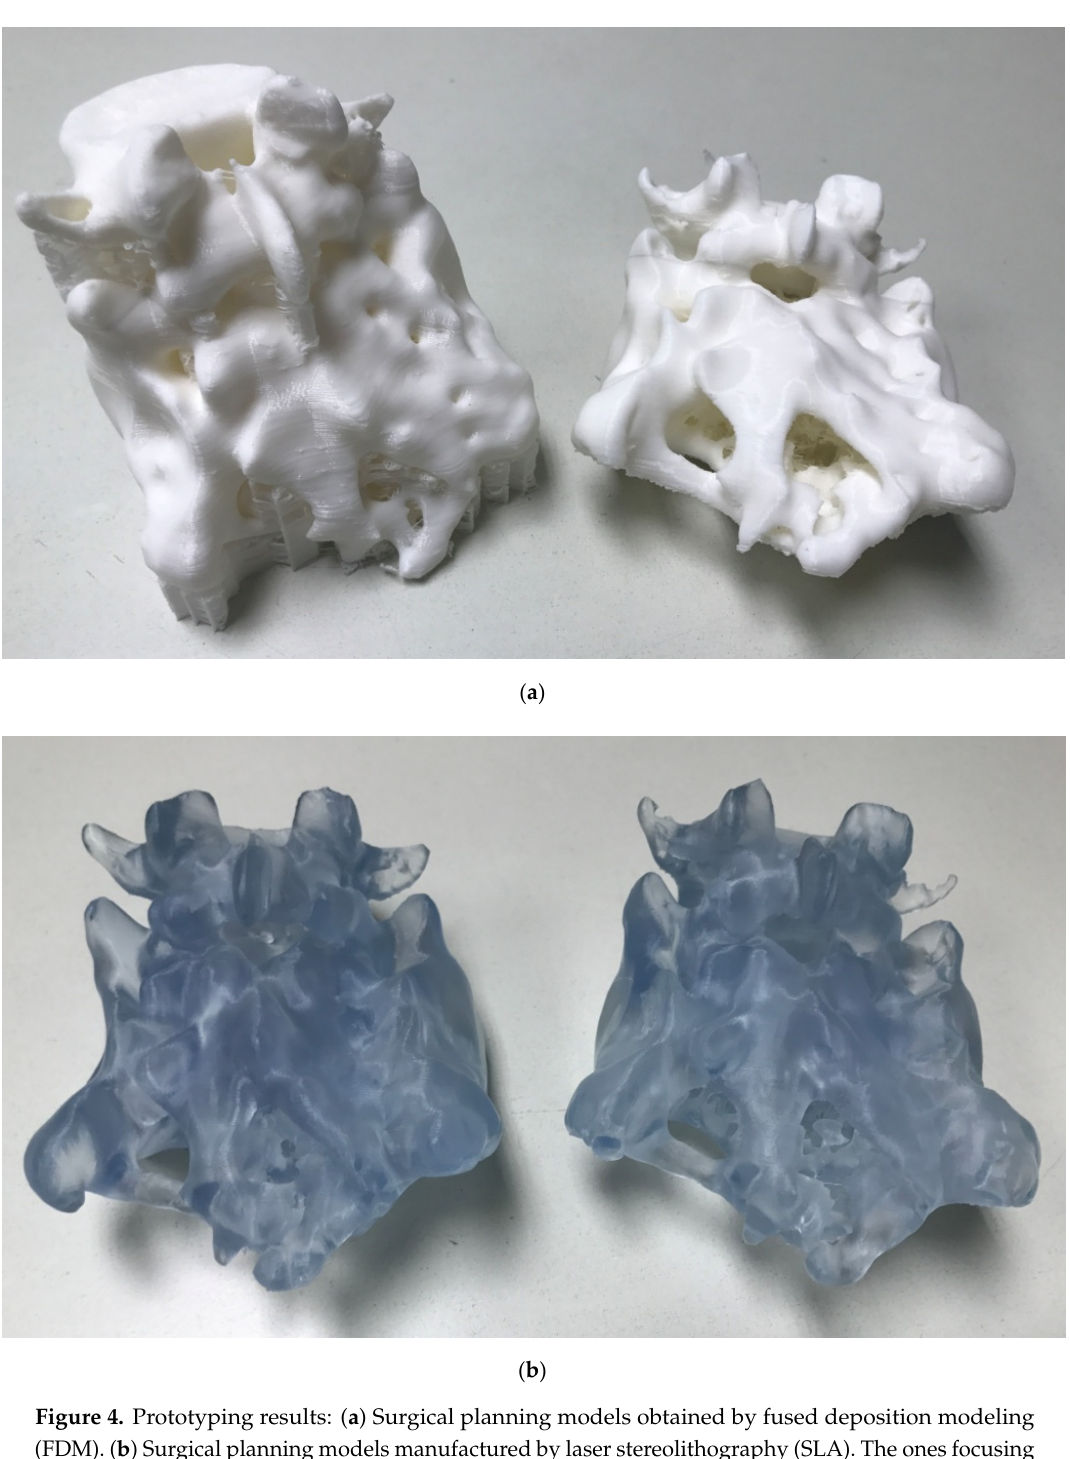
Figure 4. Prototyping results: ( a ) Surgical planning models obtained by fused deposition modeling (FDM). ( b ) Surgical planning models manufactured by laser stereolithography (SLA). The ones focusing on the higher densities (right images segmentation (B) provide more detailed bone structures, with the actual existing channels for planning the access of the electrodes for stimulation, than those including also the lower densities (left images: segmentation (A). Scale bars: 90mm.